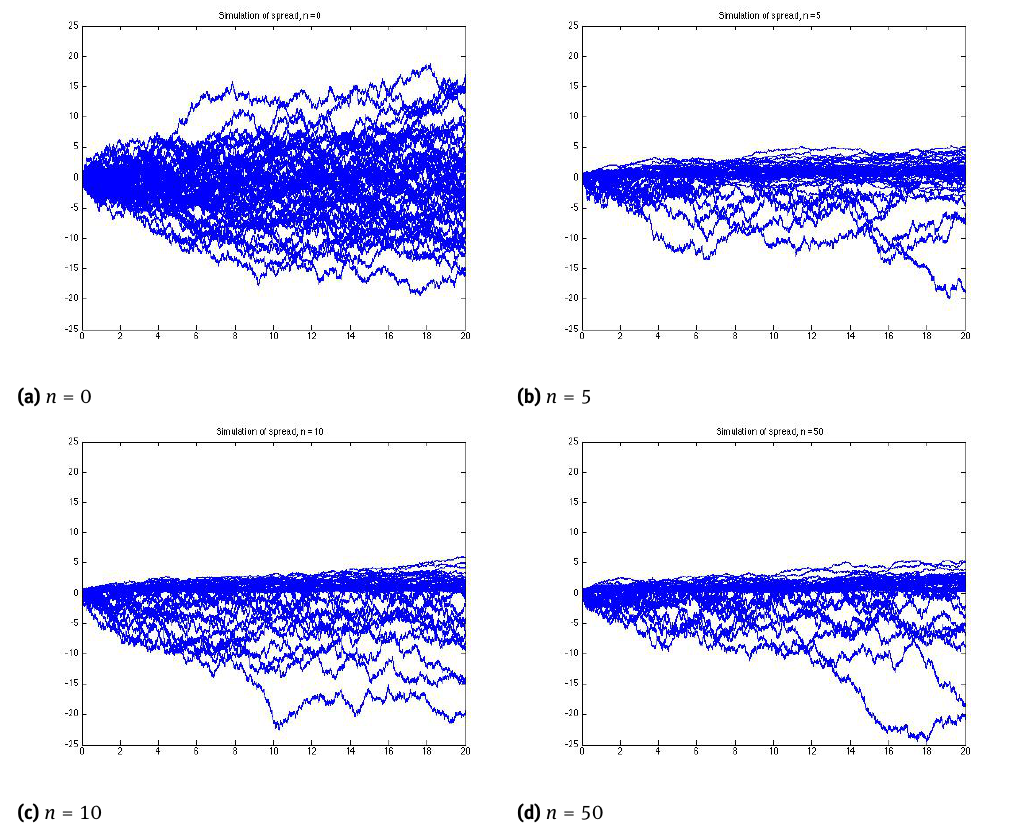
Figure 6: 50 simulations of X − Y n in the multi-barrier correlation model between time 0 and 20 with parameters ν = 0, η = 0.5 and ρ = 0.9 and a time step of 0.001 for different values of